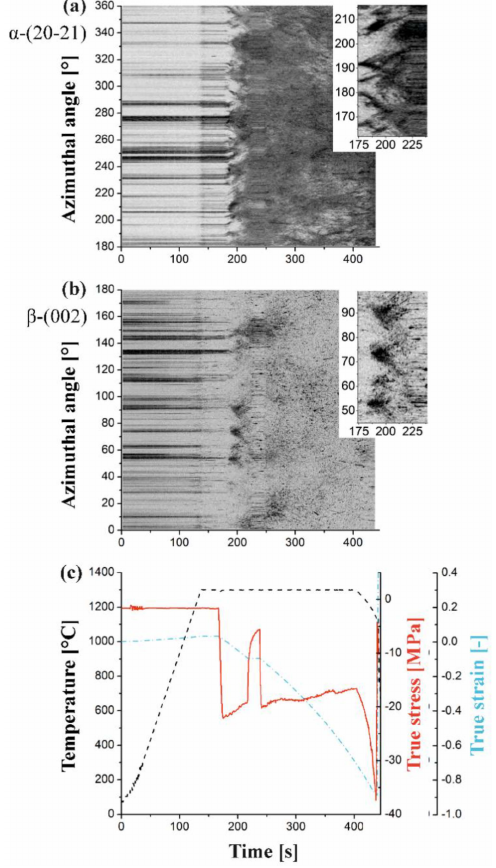
Figure 12. Azimuthal angle vs. time (AT) plots of the α 2 / α -(20-21) ( a ) and the β o / β -(002) reflections ( b ) illustrating the hot deformation behavior of a TNM alloy. The temperature profile, true stress and true strain are given as a function of time ( c ). The in situ deformation experiment was conducted within the ( α + β ) phase field region [112]. (Reproduced with permissions from Reference [52]. Copyright © Wiley-VCH Verlag GmbH & Co. KGaA, Weinheim, Germany,